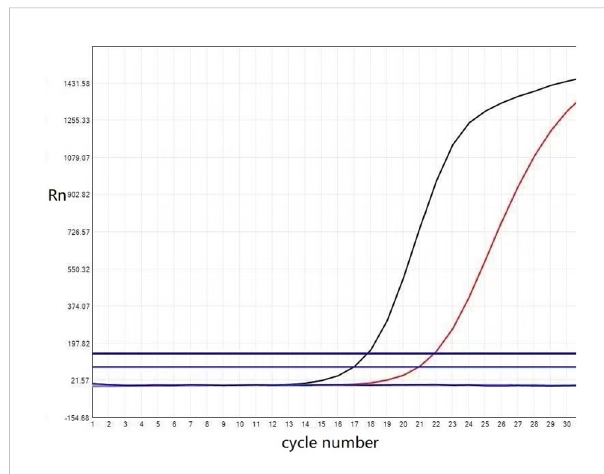
FIGURE 3 The KRAS mutation status of the papillary renal neoplasm with reverse polarity. Real-time fl uorescent quantitative polymerase chain reaction analysis showed the KRAS mutation was present in exon 2- codon 12: p.G12V (c.35 G